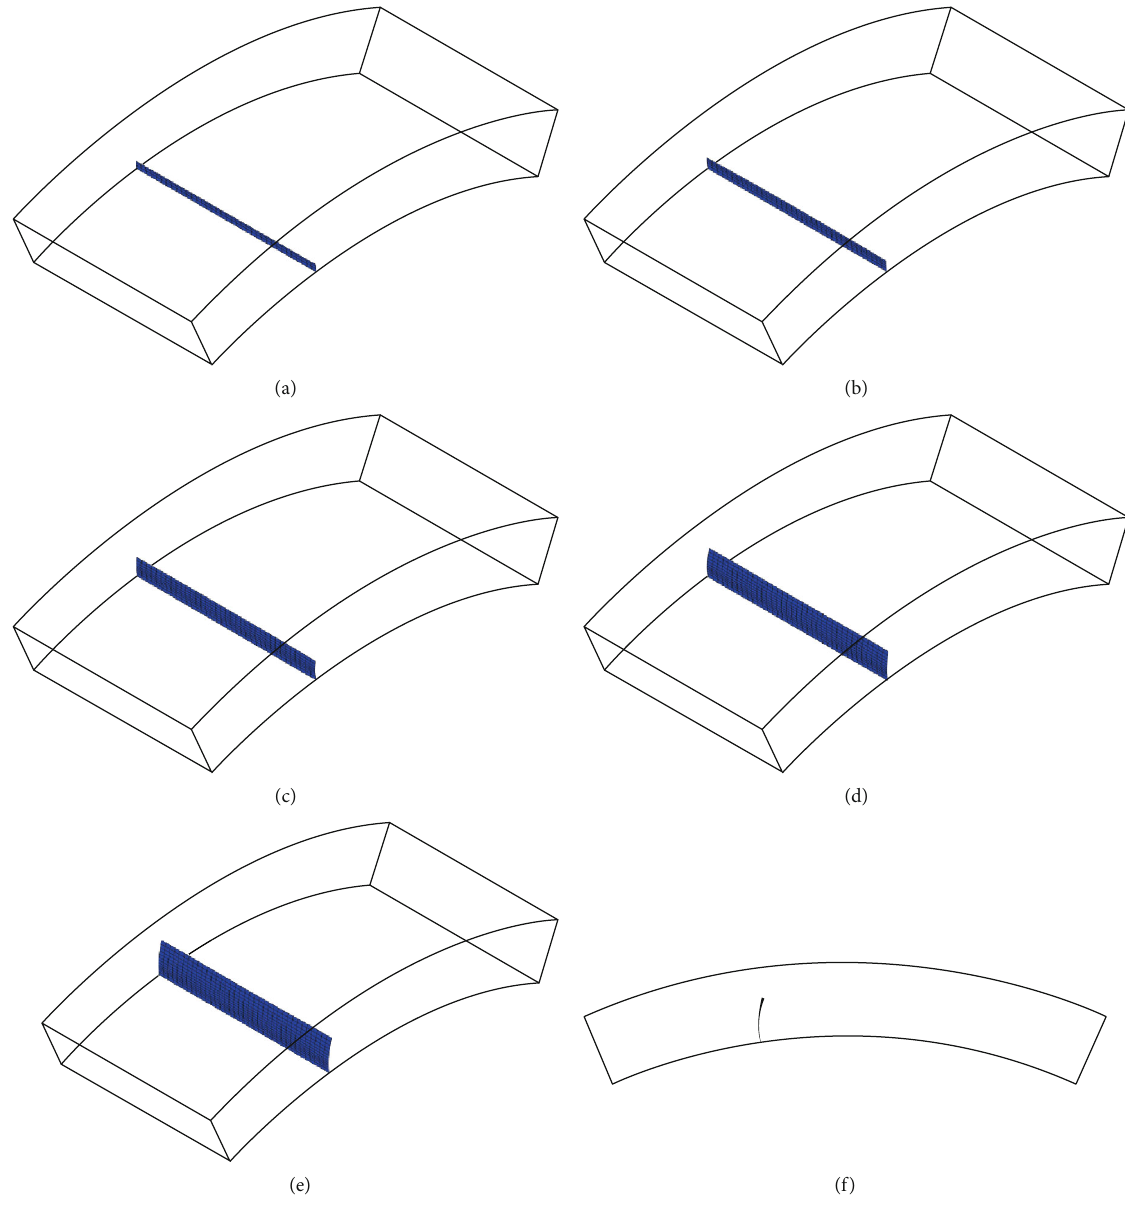
Figure 11: Crack propagation in tunnel lining segment of numerical model Z1: (a – e) 3D view; (f) 2D view (the fi nal crack in the